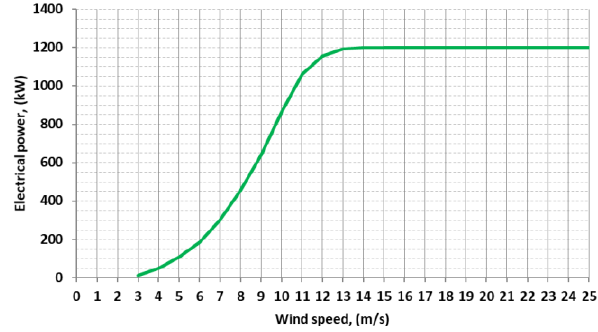
Figure 16. Course of power curve for T1 turbine—manufacturer data.